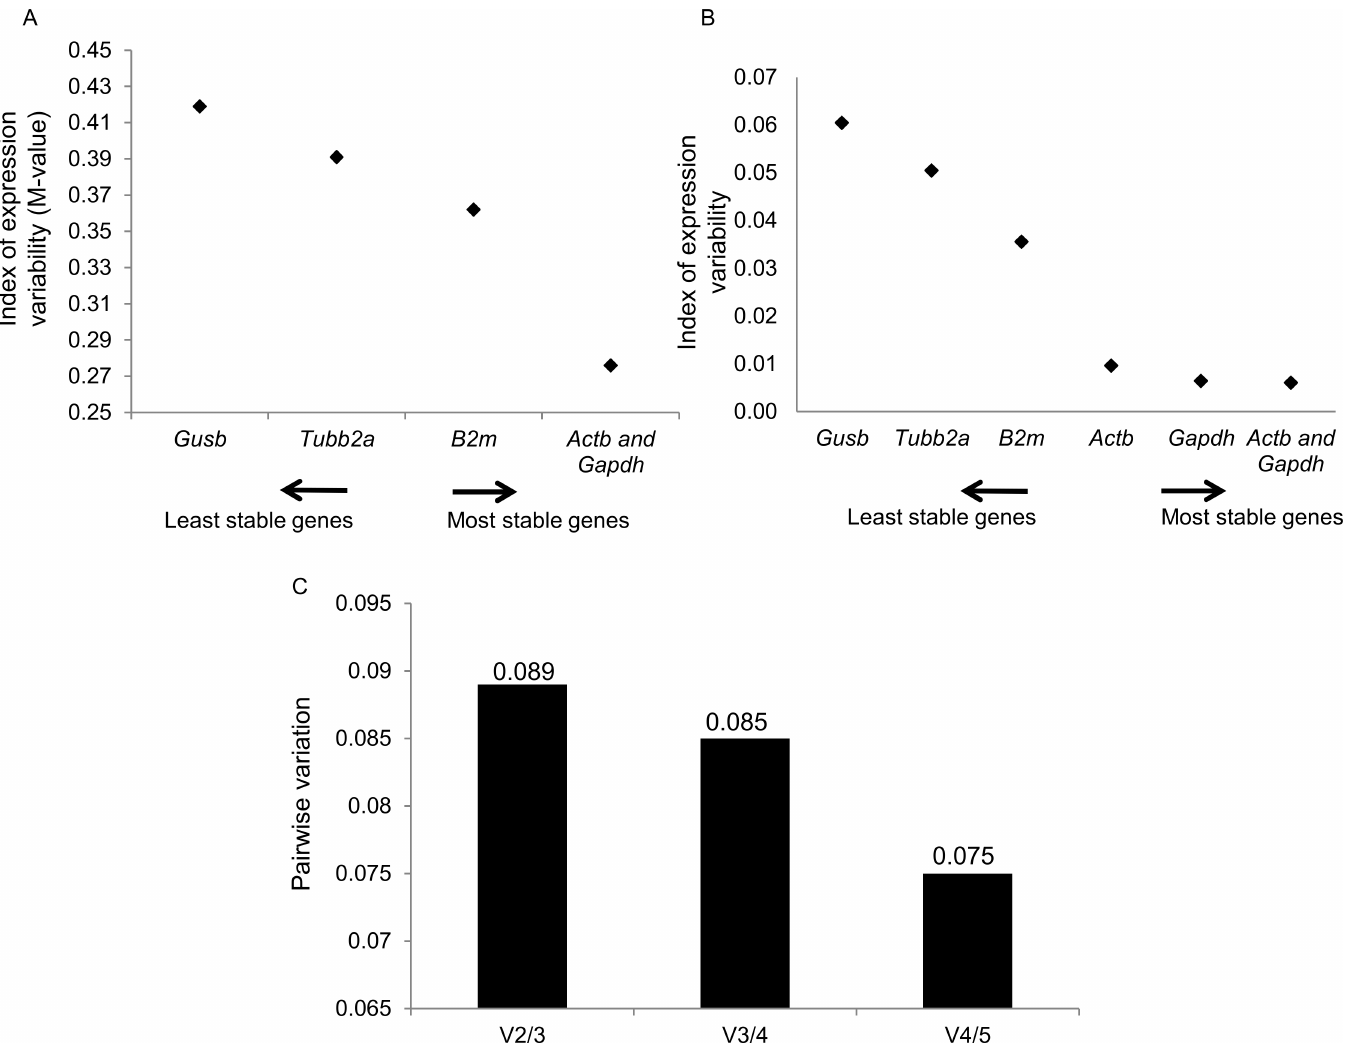
Fig 1. Selection of the most suitable referencegenes for 0h and 6h PMI in the hippocampus of Na ï verats. Expression stability measurements for the 5 reference genes calculatedby geNorm (A) and NormFinder(B). The x-axis from left to right indicatesthe ranking of the genesaccordingto their expression stability; lower values indicate higherexpressionstability. C) Determination of the optimalnumber of reference genes for normalization by geNorm. The Software calculatesthe normalizationfactor from at least two genes at which the variableV defines the pair-wise variationbetweentwo sequential normalization